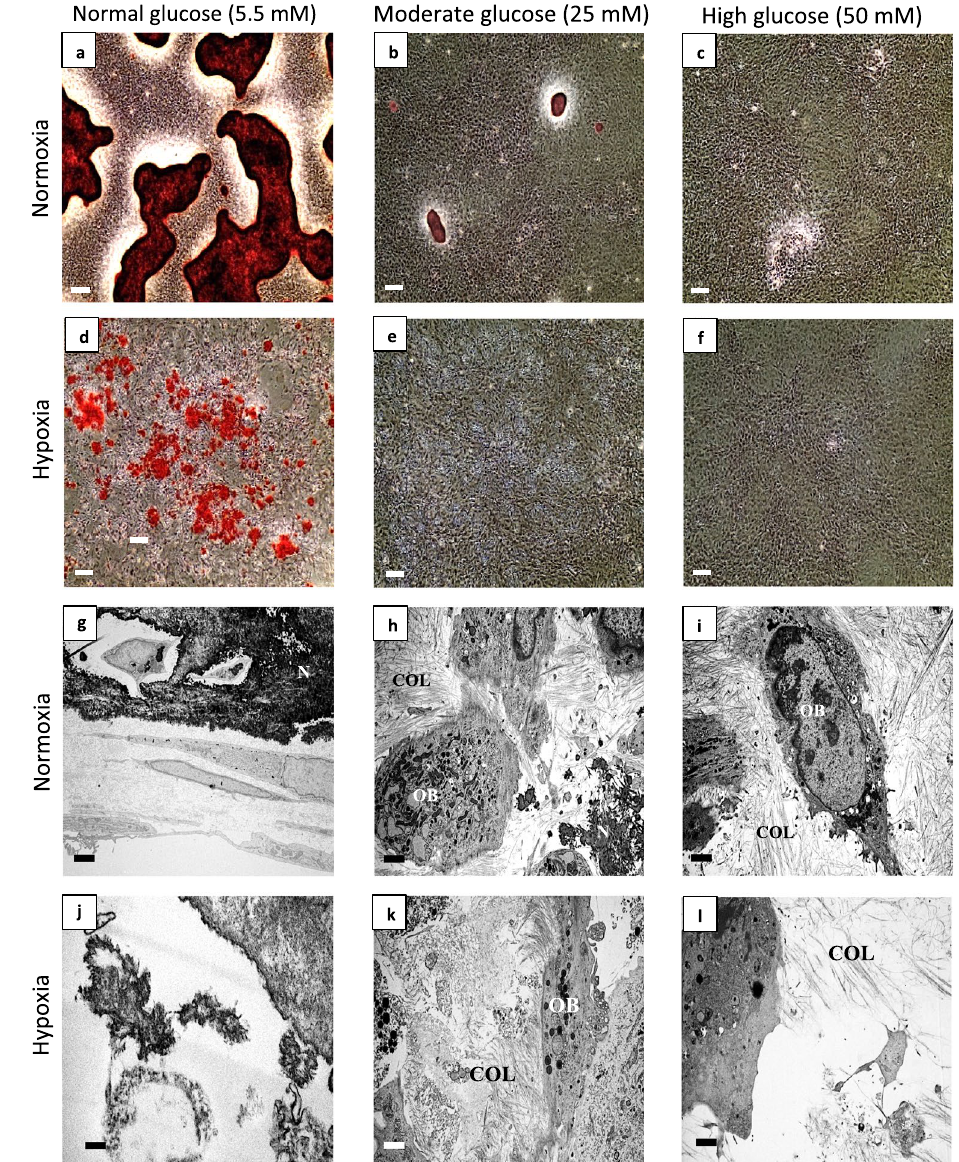
Figure 1. Hypoxia (1% O 2 ) and hyperglycaemia inhibited bone nodule formation. After 21 days, Alizarin Red stained (ARS) dense nodules were observed in ( a ) normal (5.5 mM) glucose, whilst ( b ) moderate (25 mM) and ( c ) high (50 mM) glucose conditions inhibited nodule formation. ( d ) Hypoxia normal glucose showed discrete biomineralisation that was not associated with collagen fibres. ( e ) Moderate and ( f ) high glucose inhibited biomineralisation. Transmission electron microscopy (TEM) micrographs of ( g ) normoxia normal glucose, ( h ) moderate glucose and ( i) high glucose showed a glucose concentration dependent inhibition of bone nodule formation. COL fibres were not observed in ( j ) hypoxia normal glucose, but ( k ) moderate and high glucose environments in hypoxia showed some collagen fibres. Scale bar for ( a – f ) is 200 µm and for ( g – i ) is 2 µm. (n = 5) (N: nodule, COL: collagen fibres, OB: